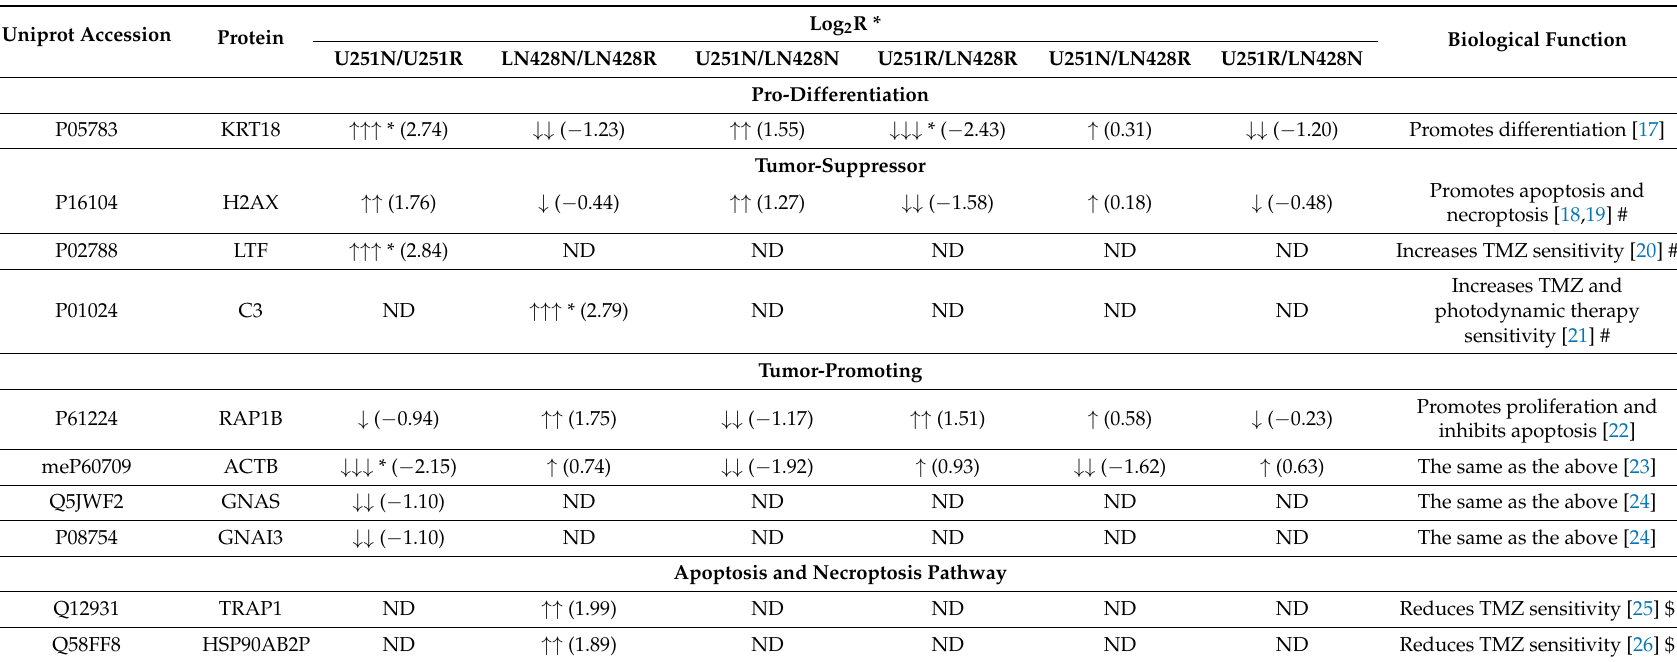
Table 1. Representative proteins in exosomes and their quantitative changes by resveratrol in U251 and LN428